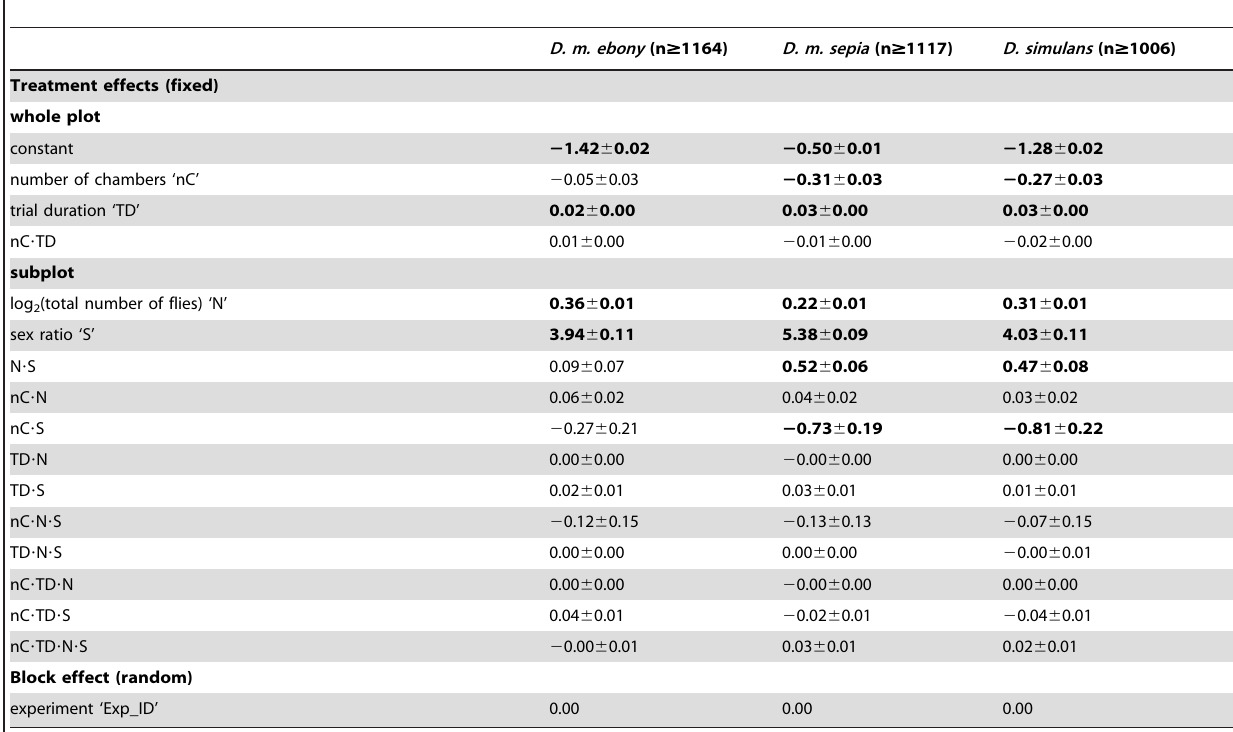
Table 3. Results of the (logistic) regression model of the ln-transformed odds of fertilization for female of three Drosophila strains in the experiments of Wallace [18] {